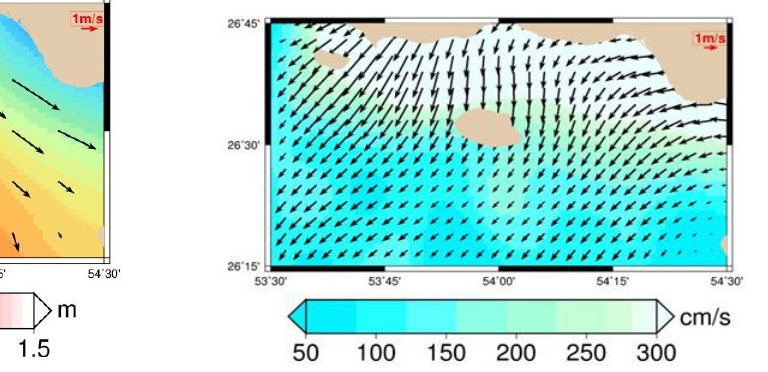
Figure 6. GCs plotted on ADT